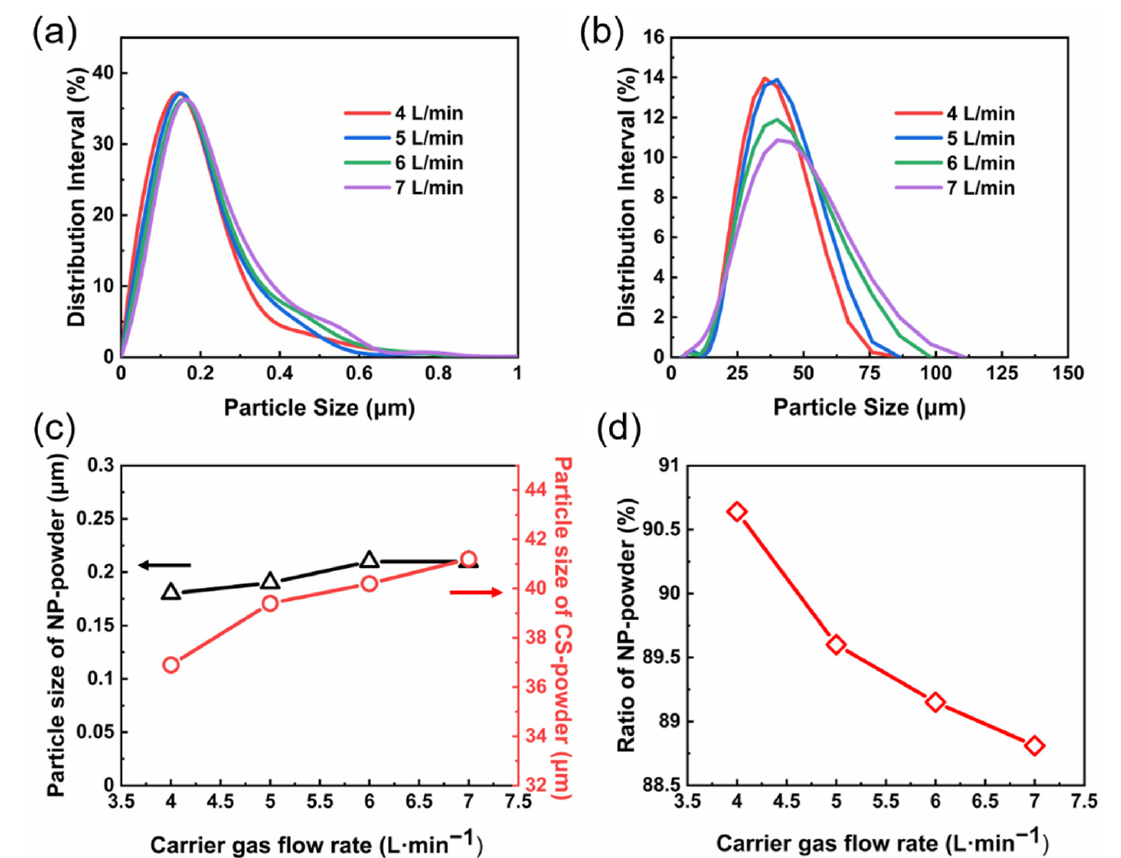
Figure 5. Particle size distribution of the ( a ) NP-powder and ( b ) CS-powder; ( c )average particle size (D 50 ) of the NP-powder and CS-powder, ( d ) ratio of the NP-powder at different carrier gas flow rates.